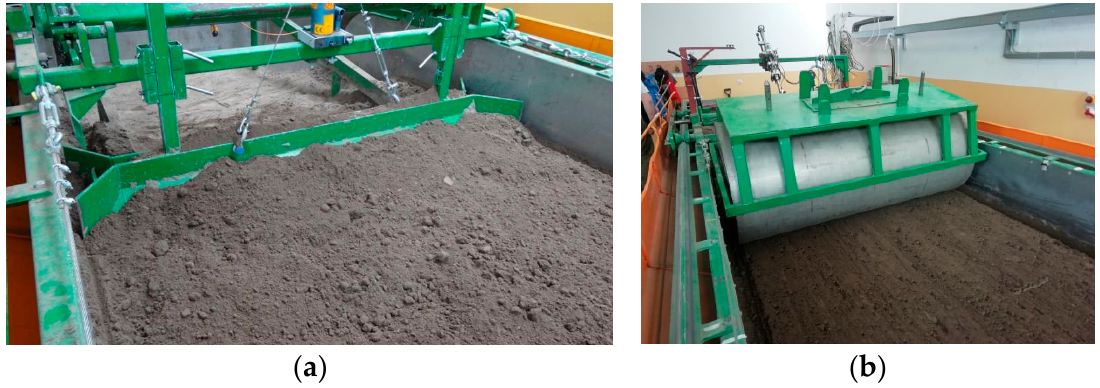
Figure 4. Levelling the soil with a two-sided scraper ( a ) and the first pass with the compacting roller ( b ) (without additional weights).